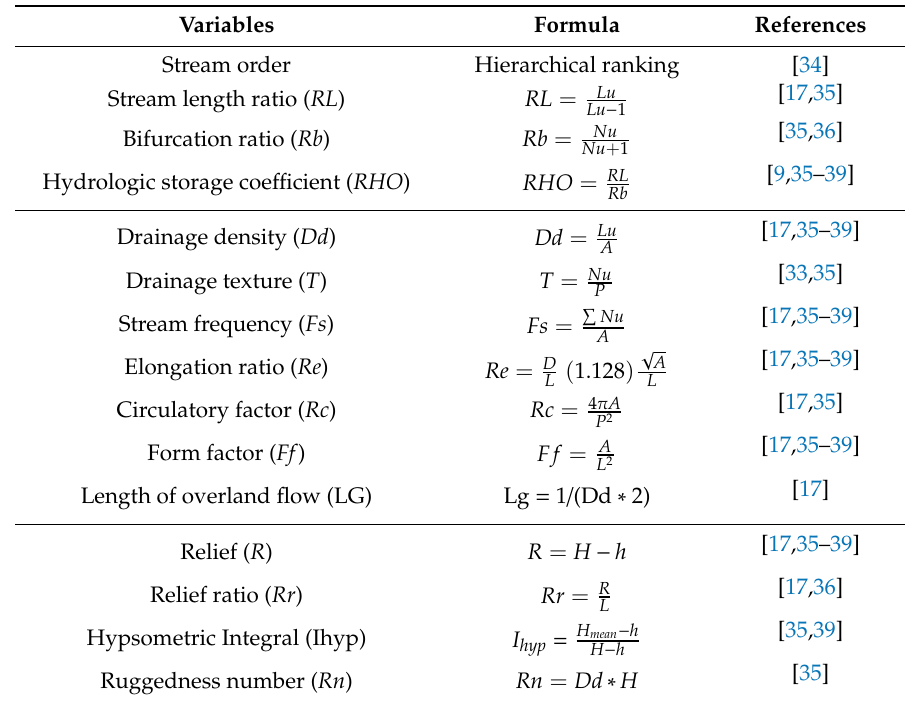
Table 2. The standard formula for the watershed characteristic